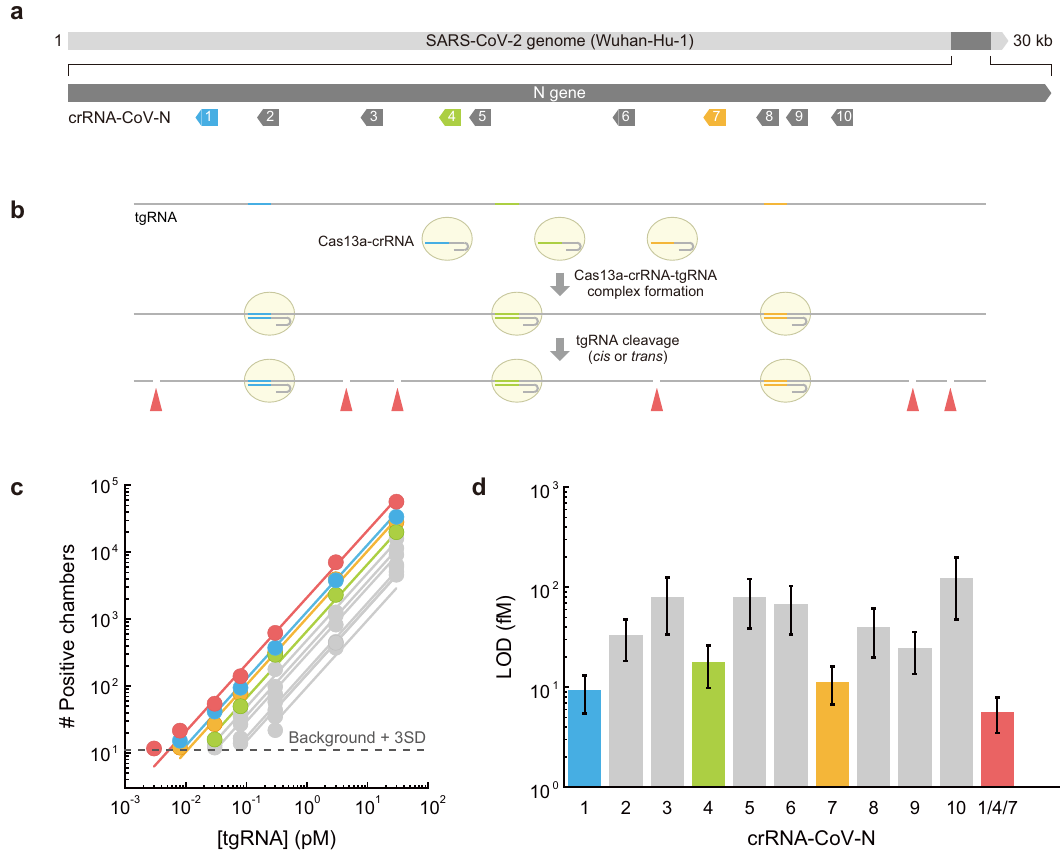
Fig. 3 SARS-CoV-2 detection by SATORI. a Schematics of the crRNAs targeting different sites in the SARS-CoV-2 N-gene (Wuhan-Hu-1). b Schematics of multiplexed SATORI. c Numbers of positive chambers obtained with the crRNAs (crRNA-CoV-N-1 – 10) at different concentrations of tgRNA (SARS-CoV-2 N-gene). Data with crRNA-CoV-N-1, -4, and -7 are colored blue, yellow-green, and orange, respectively, while those with a combination of these crRNAs are highlighted in red. Solid lines represent linear regressions. d LOD values of the SARS-CoV-2 N-gene RNA for different crRNAs.